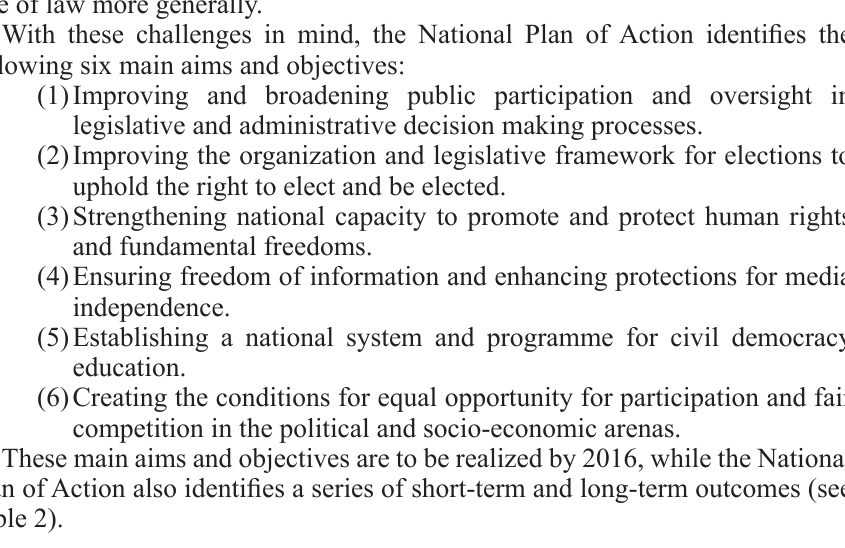
Table 2. Short-term and long-term democratic outcomes Short-term